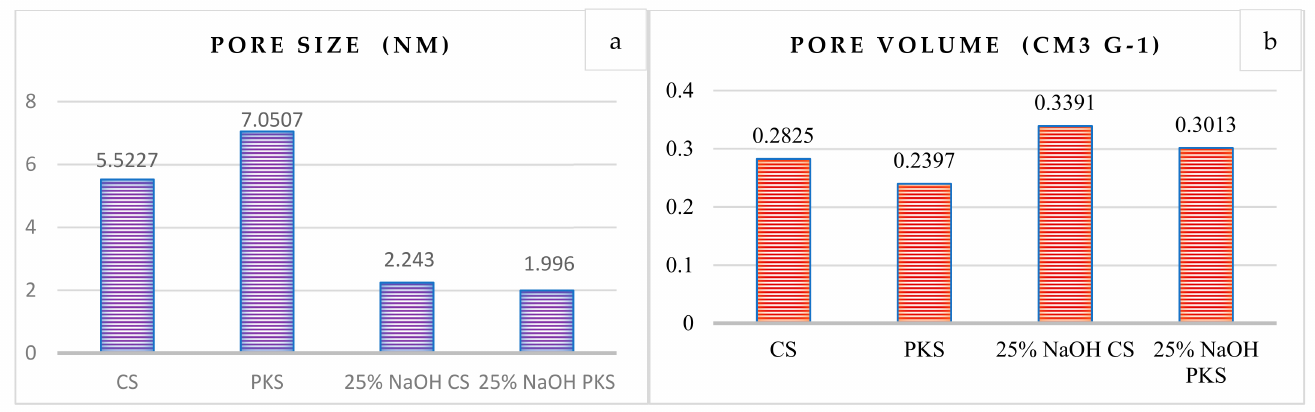
Figure 2. Pore measurements of activated carbon: ( a ) Pore size and ( b ) pore volumes for activated carbon prepared at 700 ◦ C for 75 min (reference sample) and activated carbon (700 ◦ C, 75 min) post-treated with 25%